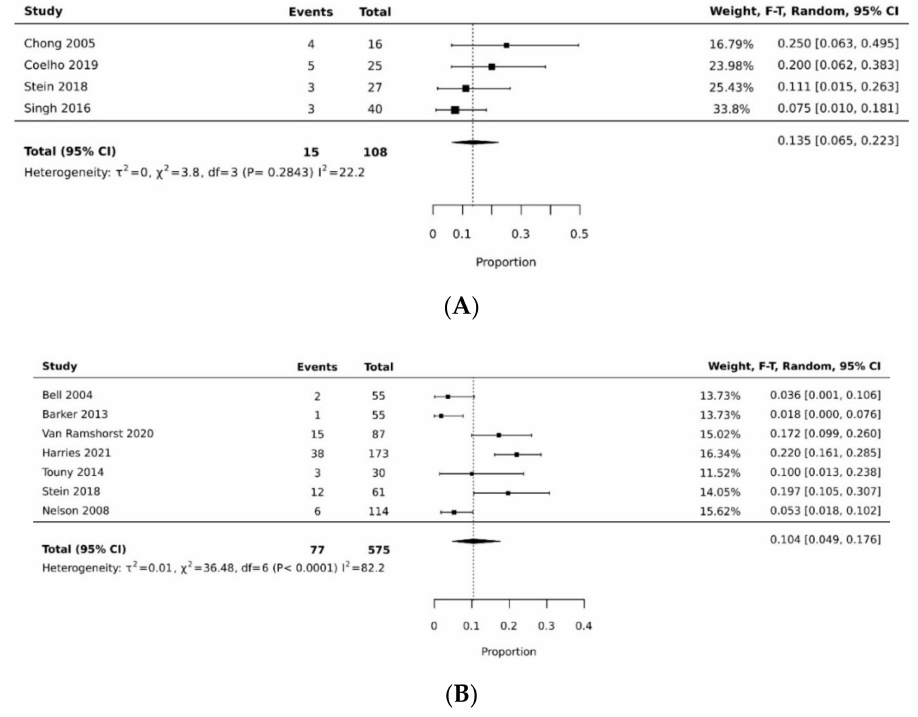
Figure 7. ( A ) Forest plot for recipient site infection rate for gracilis [21,26,35,36]. ( B ) Forest plot for recipient site infection rate for VRAM